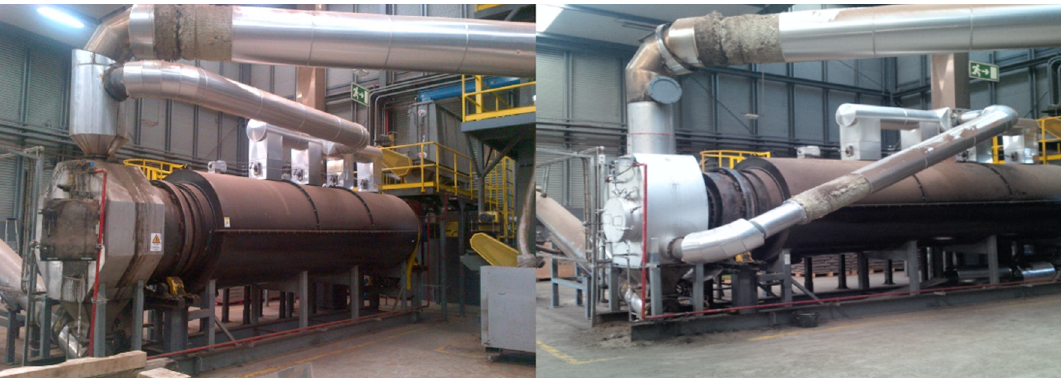
Figure 19. Left: the original unloading chamber, with a simple wall. As shown, the reactor heating gases were already conducted to guarantee the heating of the torrefaction gases. Right: in the new discharge chamber, gases started to be conducted from the bottom of the chamber, ensuring that the high temperature was maintained.